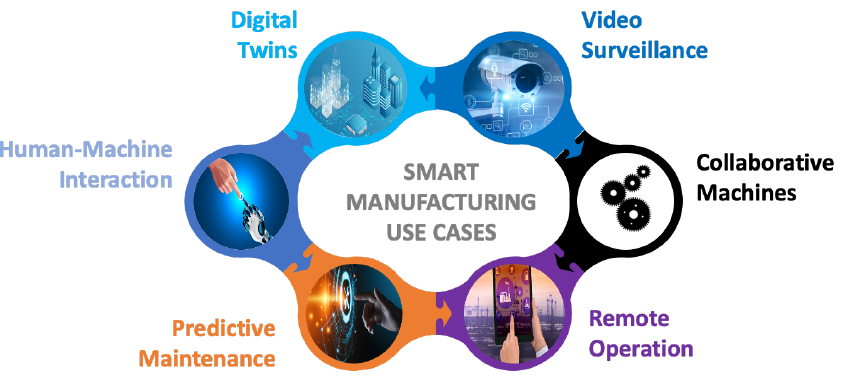
Figure 1. Examples of smart manufacturing use